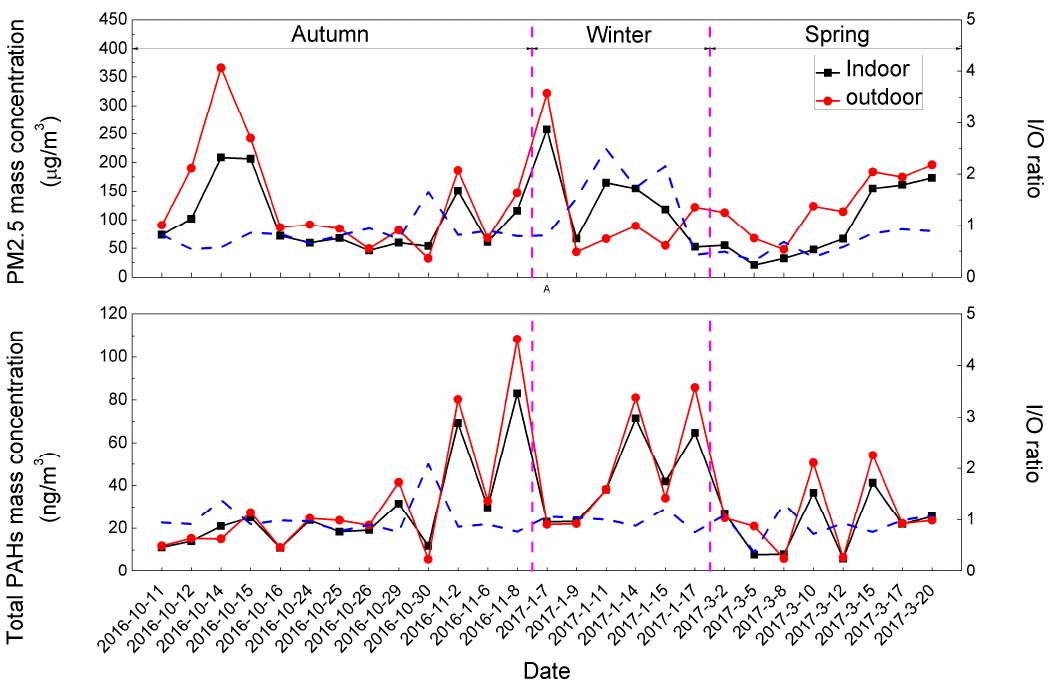
Figure 1. Time series and indoor / outdoor (I / O) ratio of PM2.5 and total PAH concentrations in indoor / outdoor air.